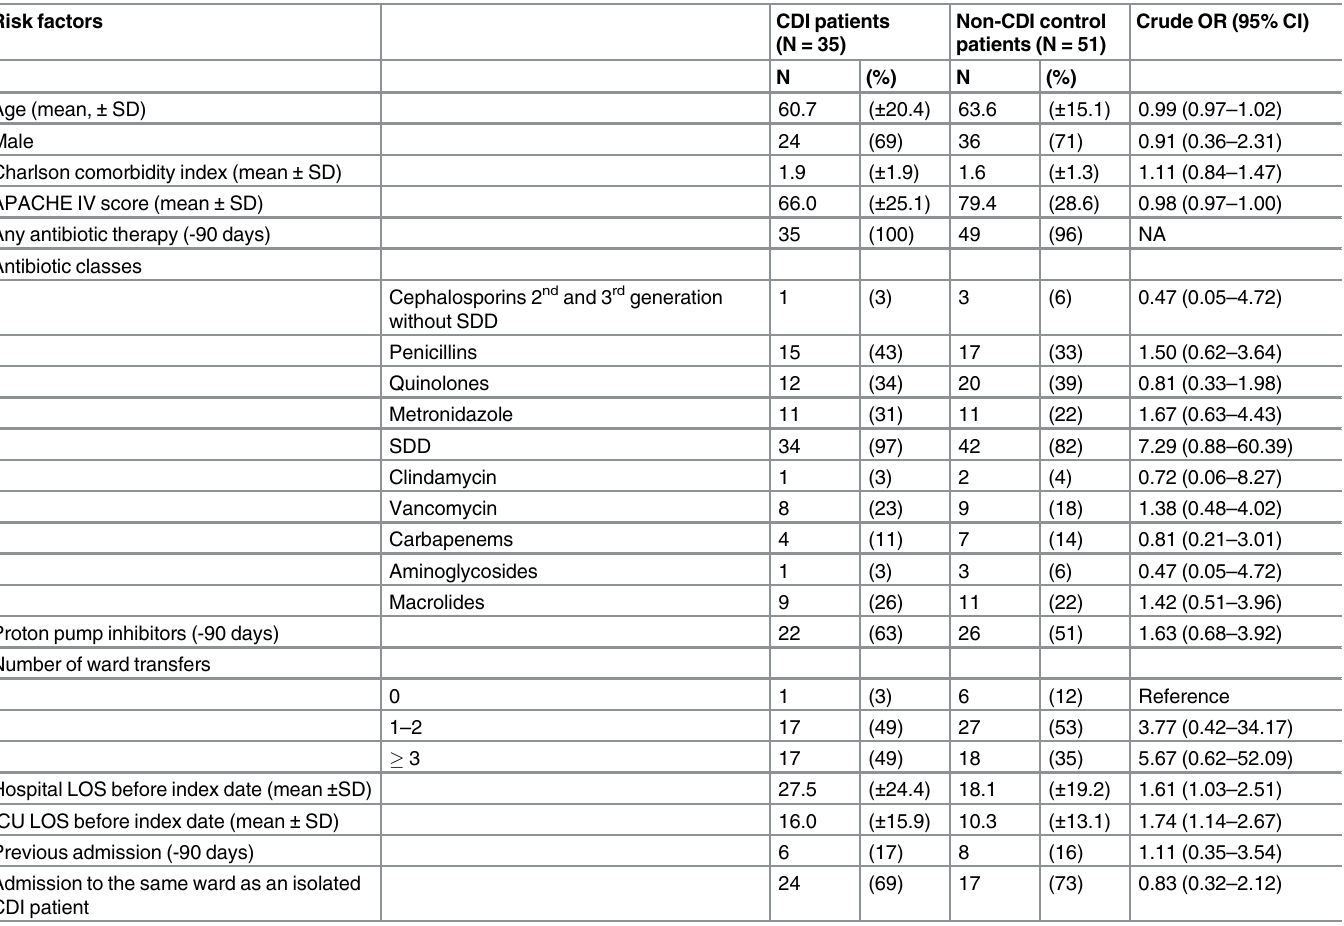
Table 4. Patient characteristics and crude odds ratios of potential risk factors for the development of CDI ribotype 027 in participants who had stayed at the